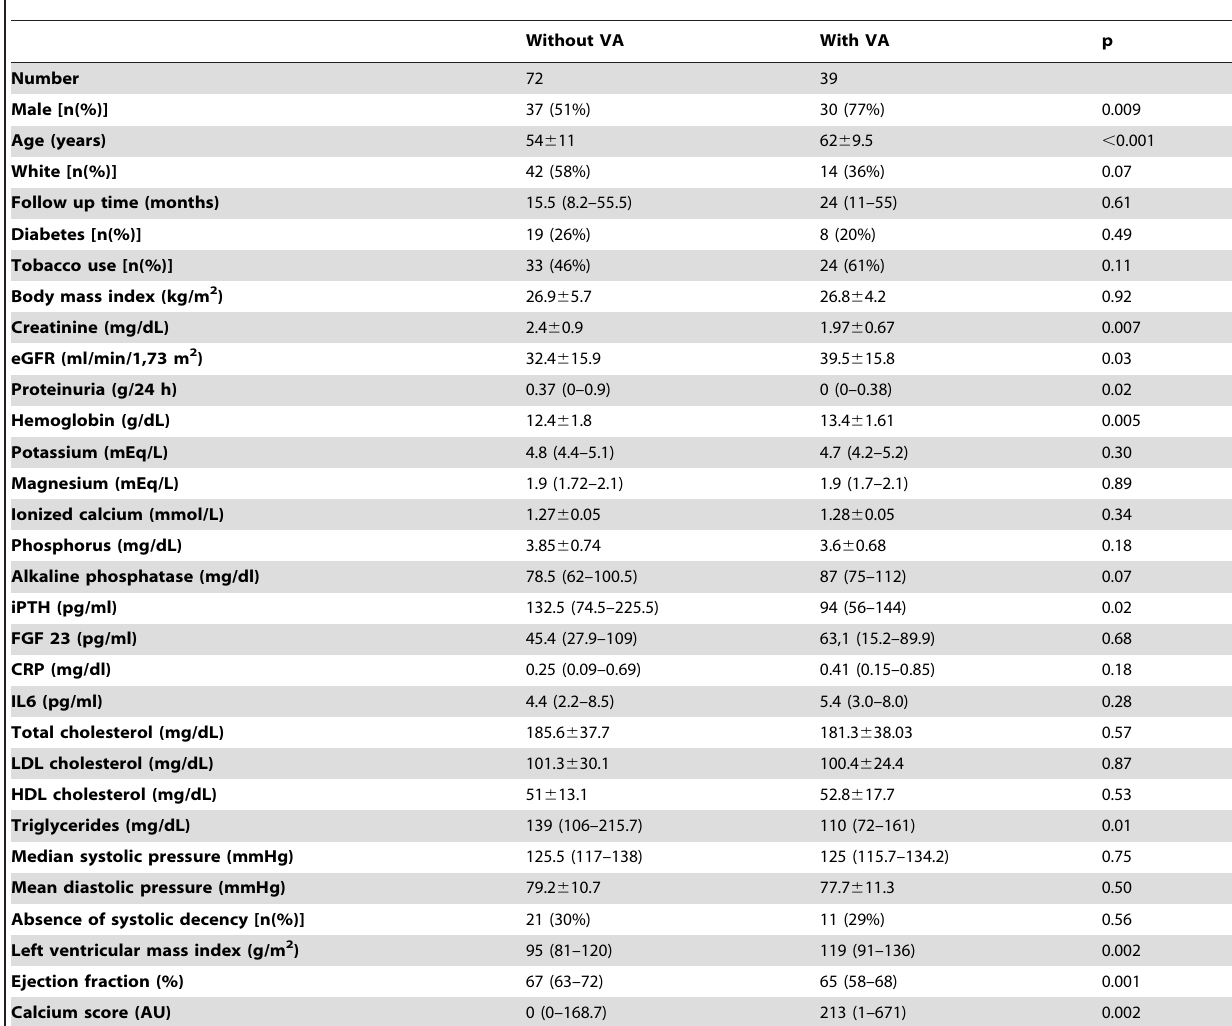
Table 2. Comparison between patients with and without ventricular arrhythmia (VA).